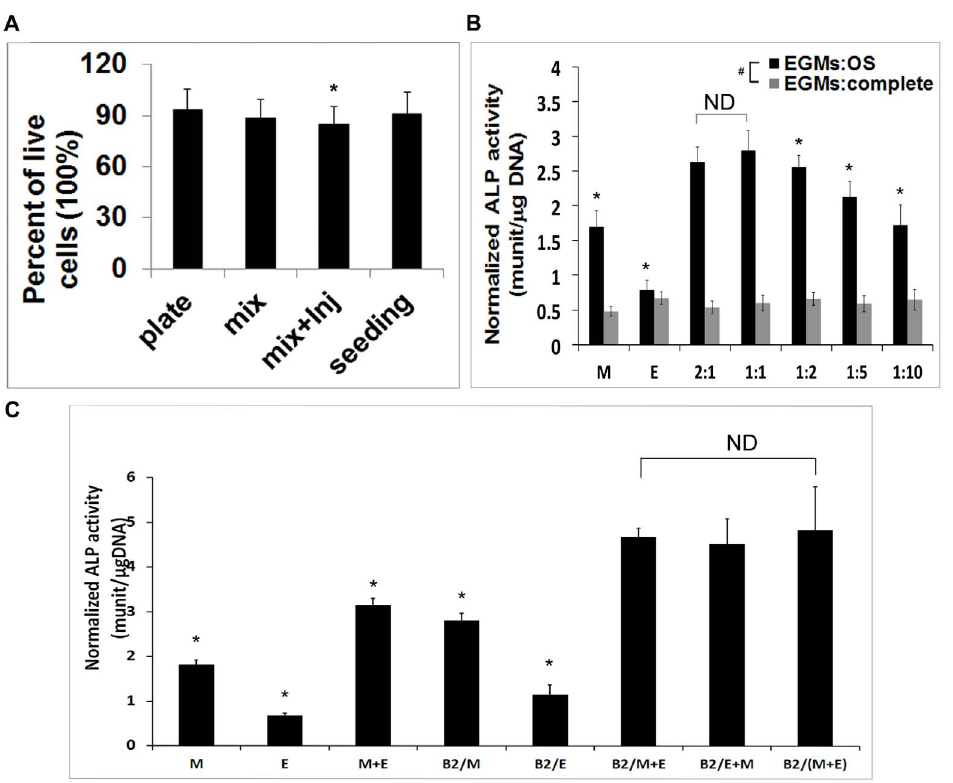
Figure 2. Co-culture of EPCs and MSCs in nCS/A scaffold. (A) MTS cell viability assay. The cell number was 5 6 10 4 per scaffold for the four groups. Data represent the mean + SD for =8. p . 0.05: between any two groups. (B) Optimization of the co-culture ratio of EPCs and MSCs. Cells were plated at EPCs:MSCs ratios of 0:1 (MSCs alone, indicate as M),1:0 (EPCs alone, indicate as E), 2:1 1:1, 1:2, 1:5 and 1:10 with a total cell number of 1 6 10 5 and then cultured in EGM/CM (EGM media: complete media ratio of 1:1) or EGM/OS media (EGM media: OS media ration of 1:1) for 7 days for ALP activity assay. ND means no significant difference between each of those three groups ( p . 0.05). Significant difference from the group of 1:1 is indicated by *( p , 0.05). # p , 0.05: all other groups between the cells treated with EGM/CM and EGM/OS media except EPCs group, which has no difference between the cells treated with EGM/CM and EGM/OS media. (C) ALP activity. MSCs, EPCs, BMP2 gene-modified MSCs and BMP2 gene- modified EPCs were respectively plated in 24-well plates at a density of 2.5 6 10 4 cells/cm 2 in the different combination. The cells were induced with EGM/OS media (EGM media: OS media ration of 1:1) for 7 days for ALP assay. Data represent the mean + SD of n =6 samples. In the groups, M: MSCs, E: EPCs, B2: BMP2, M + E: MSCs + EPCs, B2/M: BMP2 gene-modified MSCs, B2/M + E: EPCs and BMP2 gene -modified MSCs. B2/(M + E): BMP2 gene-modified MSCs and BMP2 gene-modified EPCs. ND means no significant difference between any two groups of those three groups ( p . 0.05). Significant difference from the group of B2/(M + E) is indicated by * ( p , 0.01). mineral density (BMD) showed that the BMD in nCS/A + B2/ (M + E) was significantly higher than that in the other four groups (Figure 4B). Without BMP2 gene transduction, the BMD in the nCS/A + M + E group was also significantly higher than that in nCS/A + M group and close to that in the nCS/A + M/B2 group (Figure 4A, B). 74% of BMD in the control group with normal intact calvarial bone, indicating Hematoxylin and eosin-stained sections showed that at 5 weeks following the implantation, no residual materials or inflammatory infiltrating cells were seen within any of the defect regions. In all samples, the smallest amount of new bone (black arrows) was formed in the nCS group compared with other groups, and most of defect areas were covered by fibrous like tissues (Figure 5A and A’). The nCS/A + M group formed small amounts of new bone, and most of defect areas were also covered by fibrous like tissues (Figure 5B and B’). The nCS/A + B2/M and nCS/A + M + E groups had much more bone formed in the defect area with partial coverage of the defect areas compared with nCS and nCS/A + M group (Figure 5C, C’ and 5D, D’), while nCS/A + B2/(M + E) group exhibited robust osteogenic activity, and new bone was continuous and covered almost all defect areas (Figure 5E and E’).